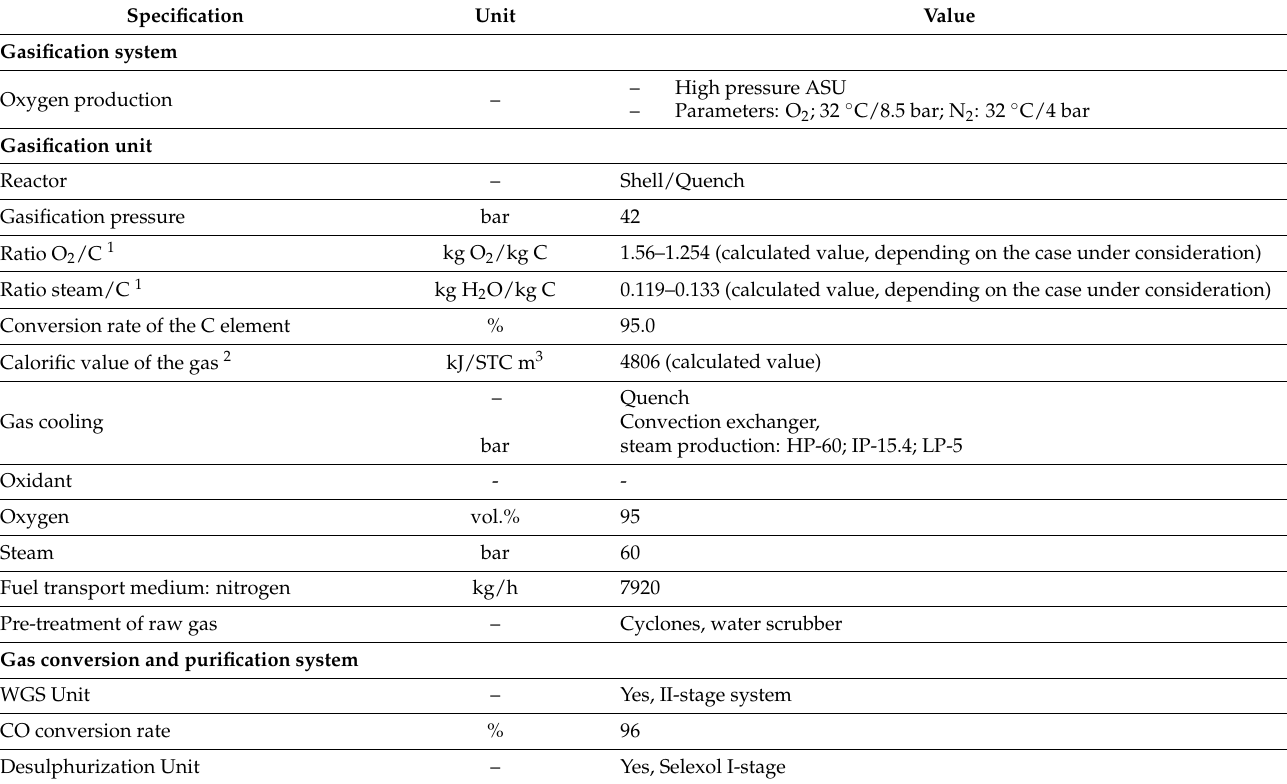
Figure 3. Process model of the gasification system (Shell Coal Gasification Process (SCGP)—Bottom water quench, ChemCAD v7). Table 1. Summary of data on the configuration of the gasification and process gas conversion sys- tem.